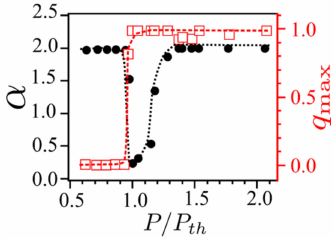
Figure 7. Lévy index α (circles) and overlap parameter | q | = q max at which the PDF P( q ) of the photonic replica overlaps with output intensity fluctuations at a maximum (squares) as a function of the normalized input power P / P th . The abrupt decrease in the parameter α at the first Gaussian-to-Lévy transition coincides nicely with the photonic phase transition observed from the q max ≌ 0 replica-symmetric paramagnetic prelasing behavior, with amplified spontaneous emission, to the q max ≌ 1 replica-symmetry-breaking (RSB) spin-glass phase of the Er-RFL system. Dotted lines are a guide to the eyes. (Reproduced with permission from ref. [68].)